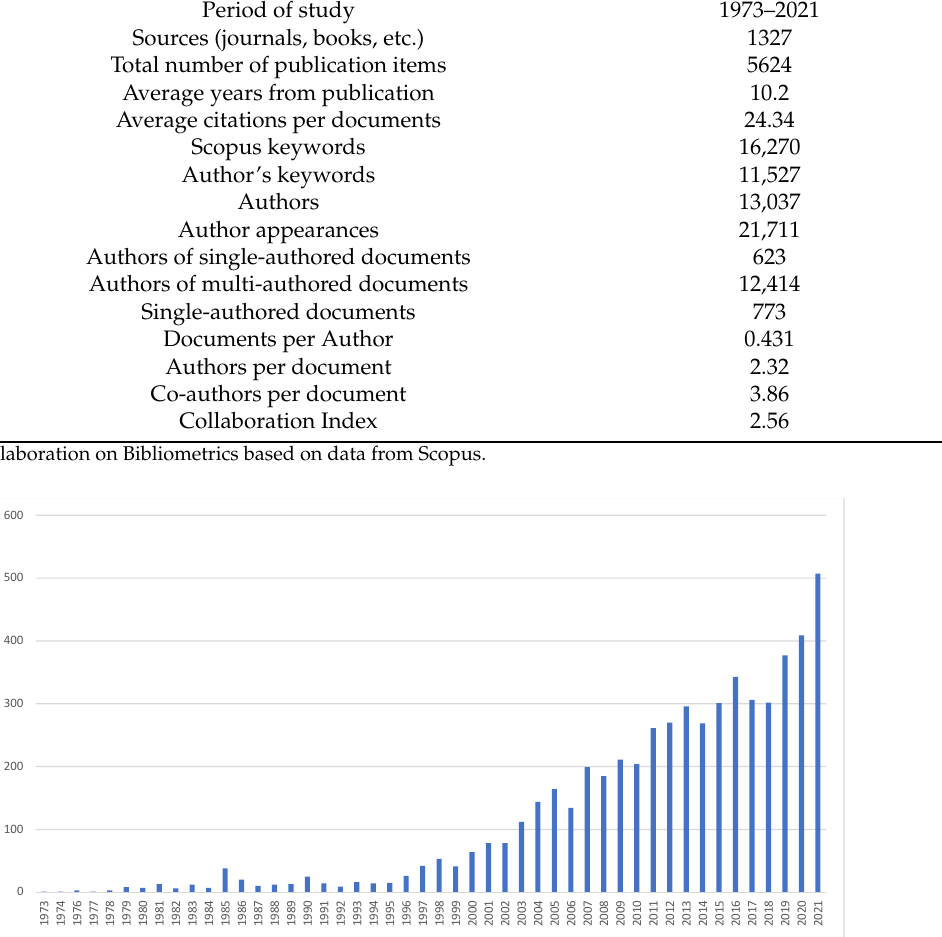
Table 1. Meta information of the database.